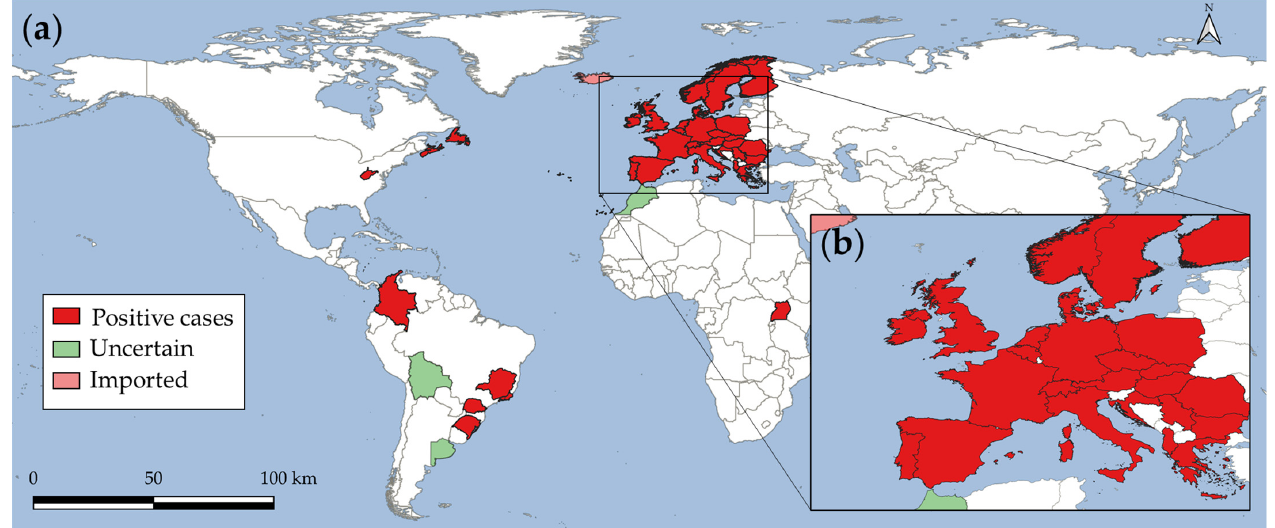
Figure 1. Worldwide geographical distribution range of Angiostrongylus vasorum . ( a ) Map shows the global location of parasite case reports in definitive and intermediate hosts. ( b ) Europe close-up.